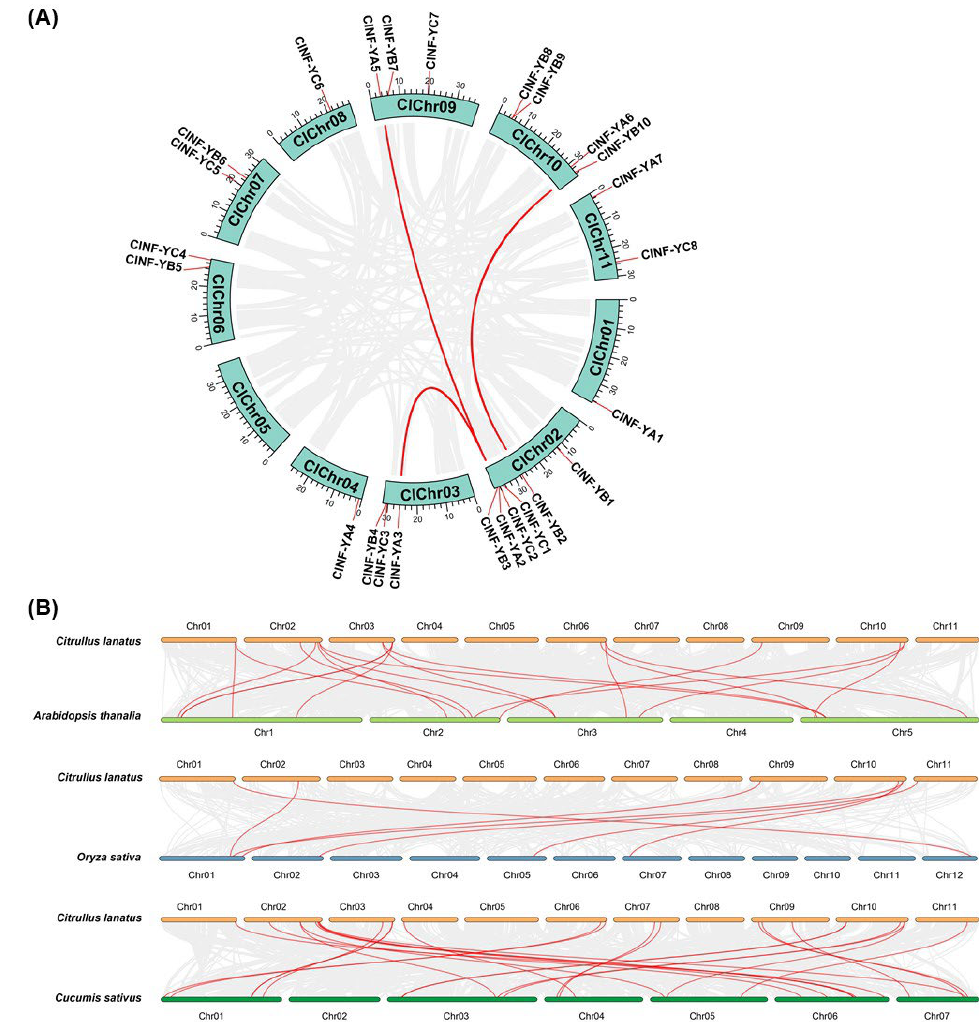
Figure 3. Interchromosomal and syntenic relationships between watermelon ClNF-Y genes. ( A ) Interchromosomal relationships between the ClNF-Y genes. Gray lines indicate the syntenic blocks in the genome, and red lines indicate the duplication of the ClNF-Y gene pairs. ( B ) Syntenic relationships between the ClNF-Y genes and NF-Y genes in other plant species. Gray lines in the background indicate the collinear blocks within the watermelon and other plant genomes, while red lines highlight the syntenic NF-Y gene pairs between watermelon and other plant